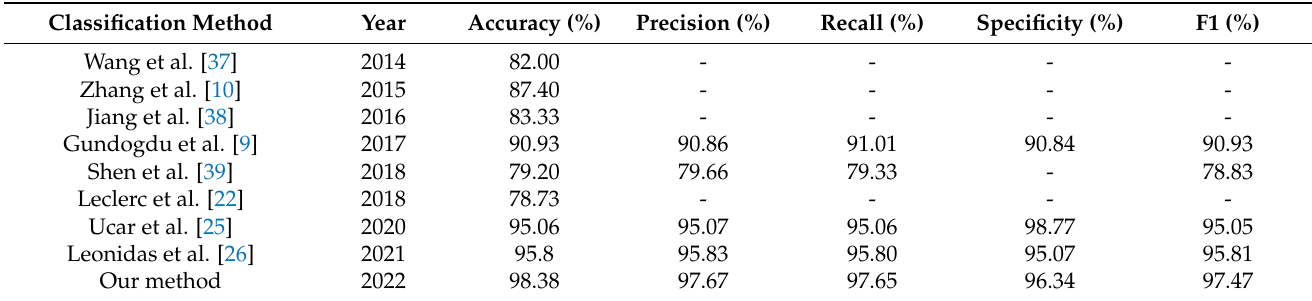
Table 8. Comparison between state-of-the-art algorithms.